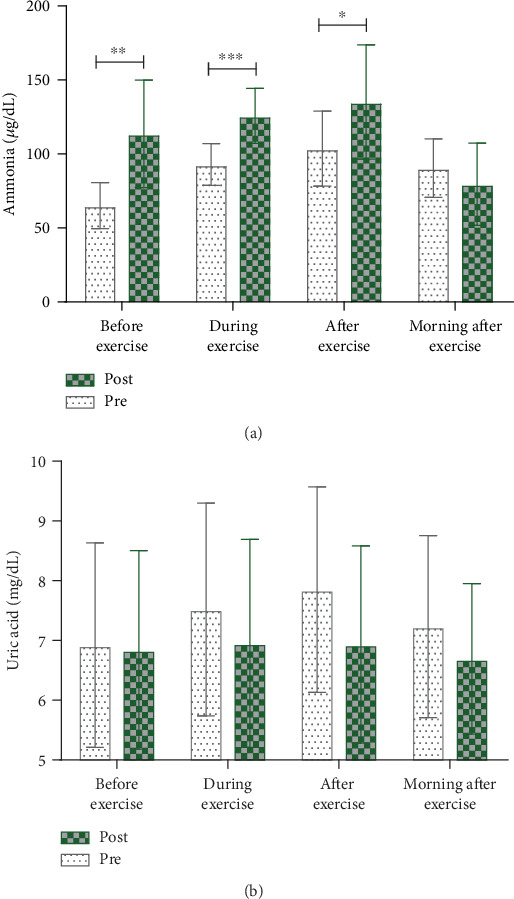
Comparison of peripheral fatigue parameters before and after MCE supplementation during the training program. (a) Both before and after MCE supplementation, ammonia levels increased from before, during, and after exercise and recovered by the next morning. Ammonia levels were higher after MCE supplementation and had a higher level of recovery. (b) Uric acid had a much lower increase after MCE supplementation than before MCE supplementation. ∗p < 0.05, ∗∗p < 0.01, ∗∗∗p < 0.001, compared to before-MCE supplementation values.